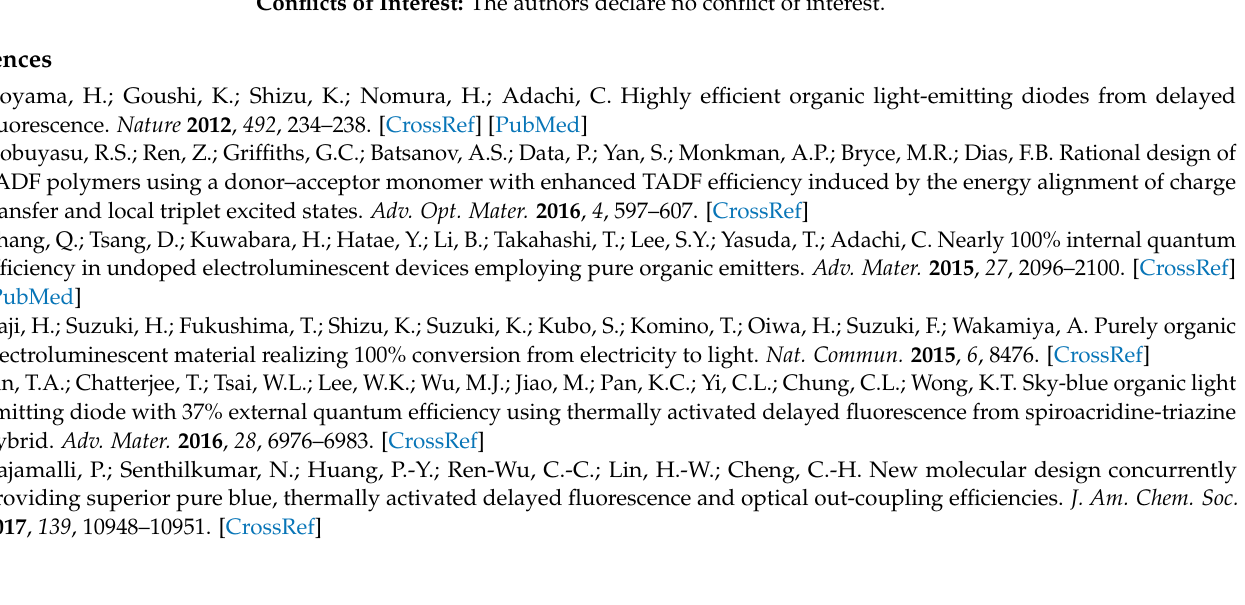
TPB:POT2T., Table S1. Average exciton lifetime of Investigated